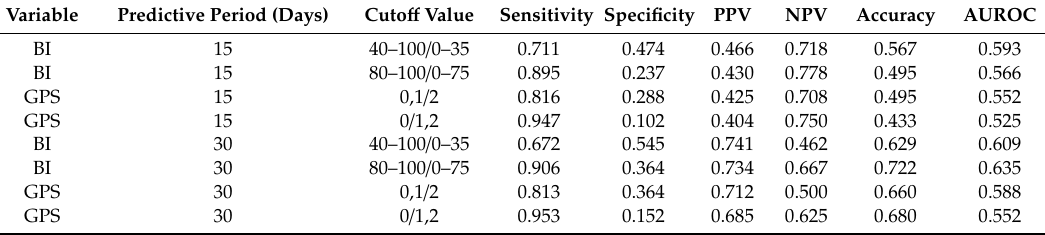
Table 2. Sensitivity, specificity, positive and negative predictive values, accuracy, and area under the receiver operating characteristic curves of the Barthel Index and Glasgow Prognostic